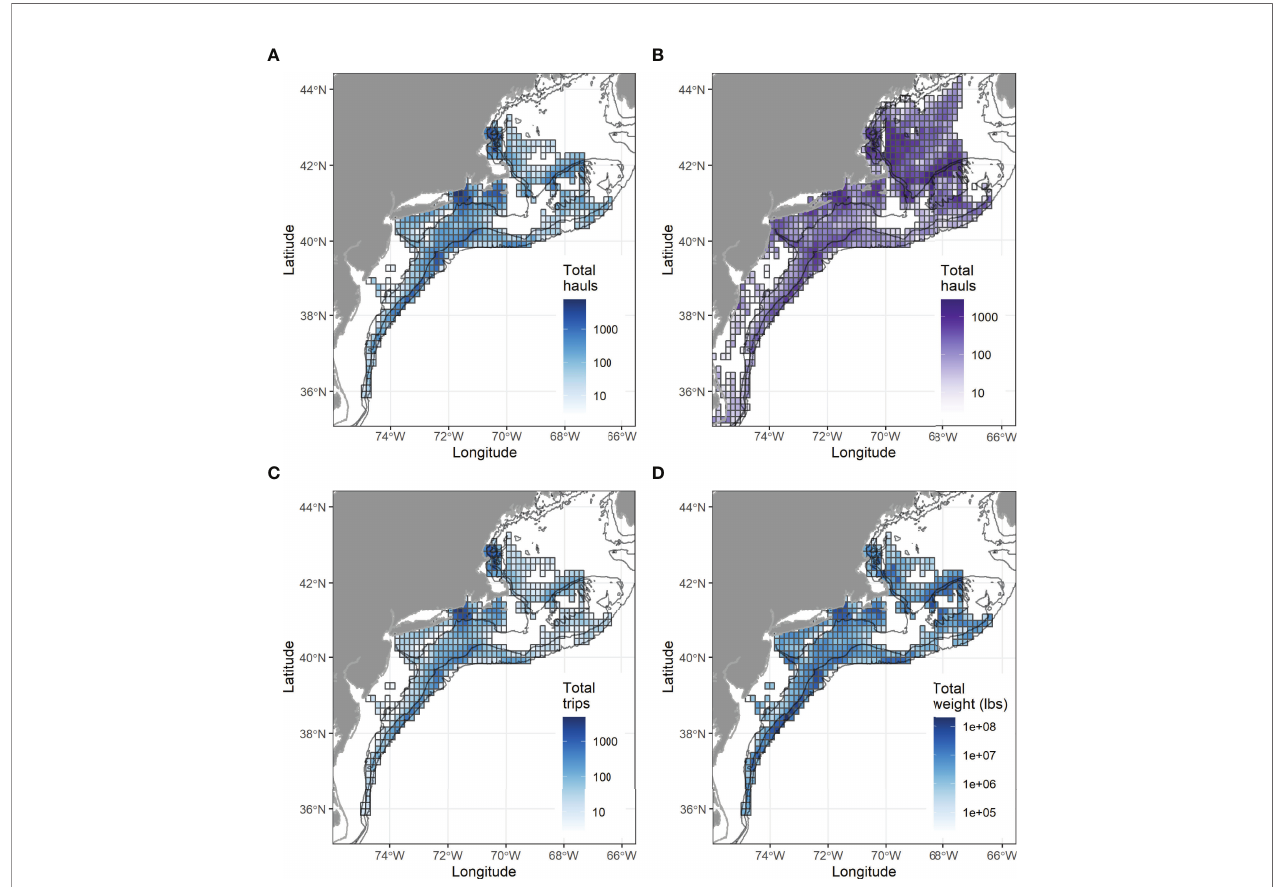
FIGURE 5 | Maps showing the spatial distribution of high-resolution fi shery dependent trawl records for 2007 - 2020 gridded into 5-minute squares. In panel (A) , the total number of Study Fleet hauls are shown. For comparison the distribution of observer records for otter trawl gear are shown in panels (B, C) shows the total number of trips by Study Fleet vessels. Panel (D) shows the total catch by Study Fleet vessels (lbs). In all panels cells with fewer than three unique permits (records from fewer than three vessels) have been omitted. In panels (A – D) 258 (55%) cells were omitted and in panel (B) 182 were omitted